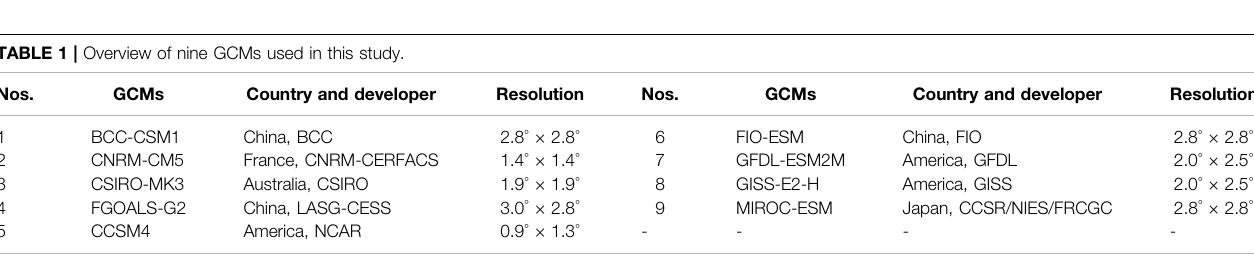
TABLE 1 | Overview of nine GCMs used in this study.